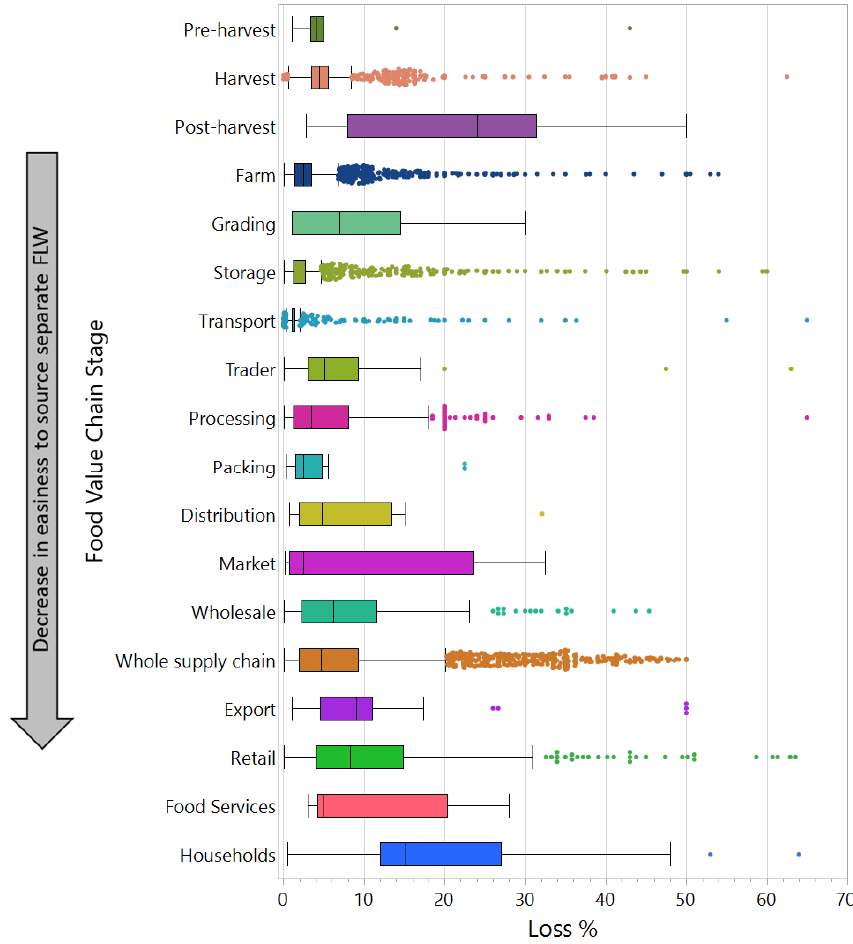
Figure 5. The global loss percentage of FLW across different stages in the food value chain from 2000 to 2022 (Adapted with permission from [115]) and decrease in easiness to separate waste in the food value chain.